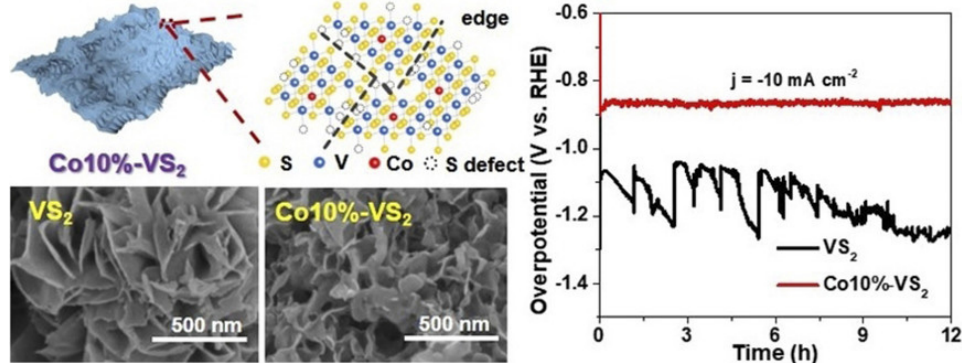
Figure 2. Preparation of Co-doped VS 2 nanosheets and its HER activity in alkaline seawater [20].